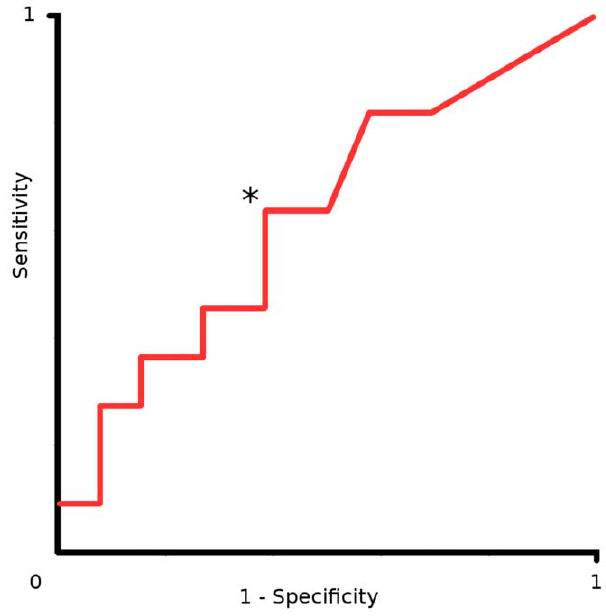
Figure 2. A receiver operator curve (ROC) was constructed to identify the fibrillation score cut-off that identified non- responders with the maximal sensitivity while preserving specificity. Sensitivity is represented on the y axis and (1-specificity) on the x axis. The asterisk (*) indicates a fibrillation score of 0.4. A score . 0.4 detected non-responders with moderate sensitivity (64%) and specificity (62%).